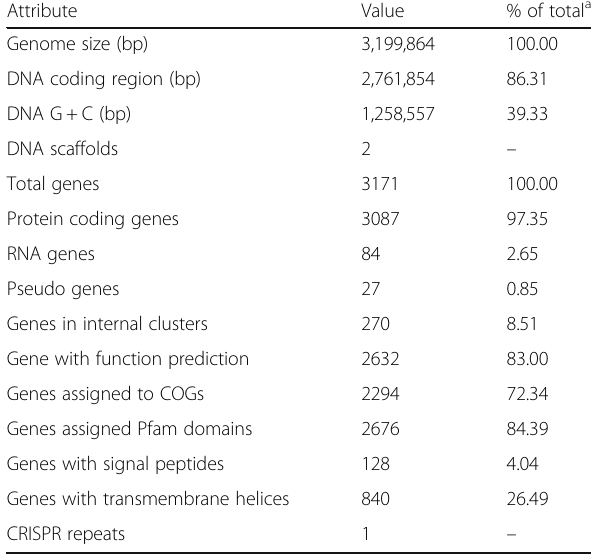
Table 3 Genome statistics of Planococcus sp.